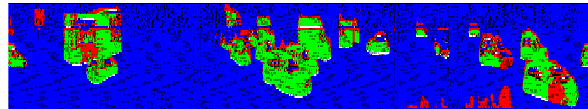
Figure 4. The validation of the neural network: true positives (green), true negatives (blue), false positives (red), false negatives (white)